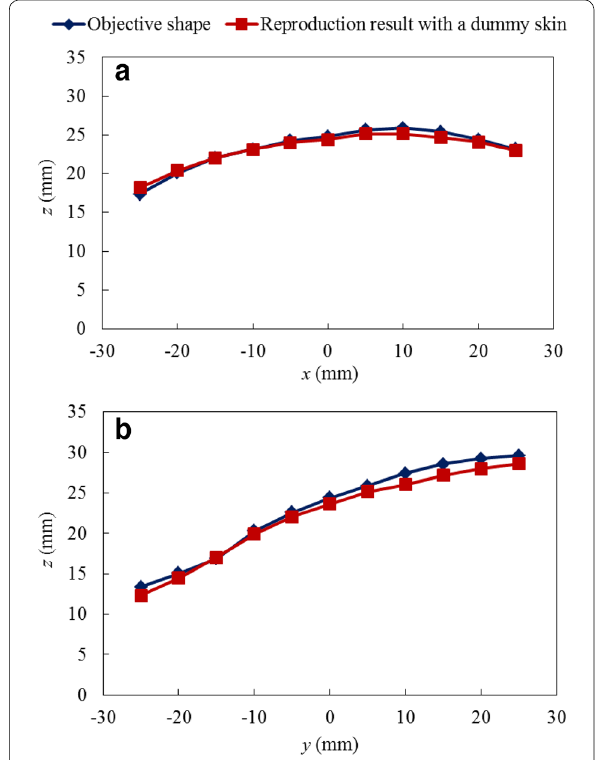
Fig. 8 Displacement comparison results. a Displacement comparison (y 5), b displacement comparison (x =